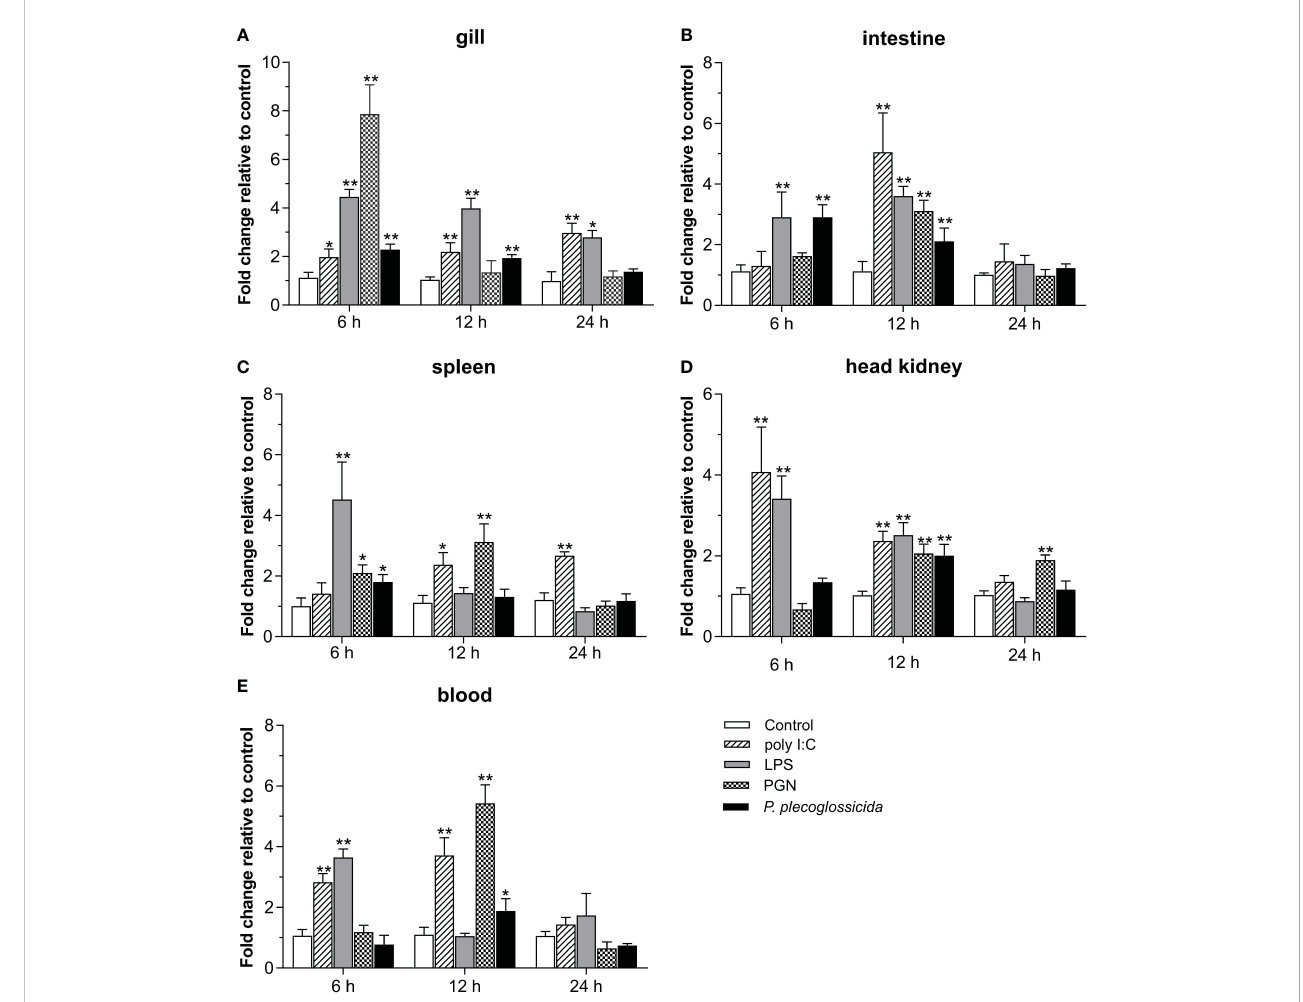
FIGURE 4 Expression analysis of Lc - TRAF7 under the stimulations of poly I:C, LPS, PGN, and P. plecoglossicida . Each fi sh of the challenge group was intraperitoneally injected with 100 m L of poly I:C (1 mg/mL), LPS (0.5 mg/mL), PGN (1 mg/mL), or P. plecoglossicida (5 × 10 5 CFU/mL), respectively. The control group was injected with the same volume of PBS solution. The expression levels of Lc-TRAF7 in the gill (A) , intestine (B) , spleen (C) , head kidney (D) , and blood (E) of the fi sh were detected by qRT-PCR at 6, 12, and 24 hpi. The expression level changes were calculated by normalization to the expression of L. crocea b -actin and then recorded as fold induction compared to the PBS injection group (control group) at the same time point. All data were shown as mean of three repeated experiments, with bars representing the SE. * P < 0.05, ** P <